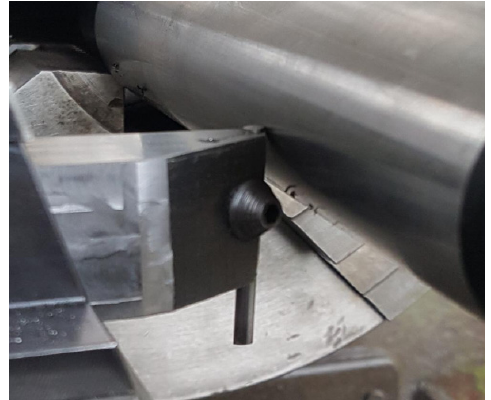
Figure 13. Tool mounted in the holder of the TUD 50 lathe.